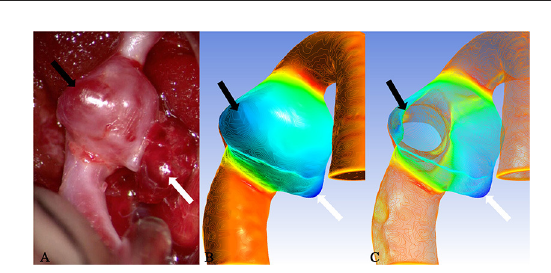
FIGURE3 Case 9: The ruptured aneurysm in the middle cerebral artery. It was usually difficult to predict the rupture point. When the tissue adjacent to the aneurysm is not properly pulled during the operation, it is easy to cause the aneurysm to rupture and bleed again. After Polyflow simulation, the rupture point of the aneurysm could be predicted before the operation or targeted during the operation, and the operation risk would be reduced. (A) The white arrow pointed the location of the rupture point. The surface was covered with a fibrin cap and the area indicated by the black arrow was a translucent area, which was corresponded, respectively, to the deeply stained parts in (B) (black arrow and white arrow). When many areas with similar deep staining appeared on the model surface, the possible position of the rupture point could be determined through the thickness value of each extreme point in (C) (the white arrow indicated the thickness of the extreme point which was thinner than that of the area indicated by the black arrow).